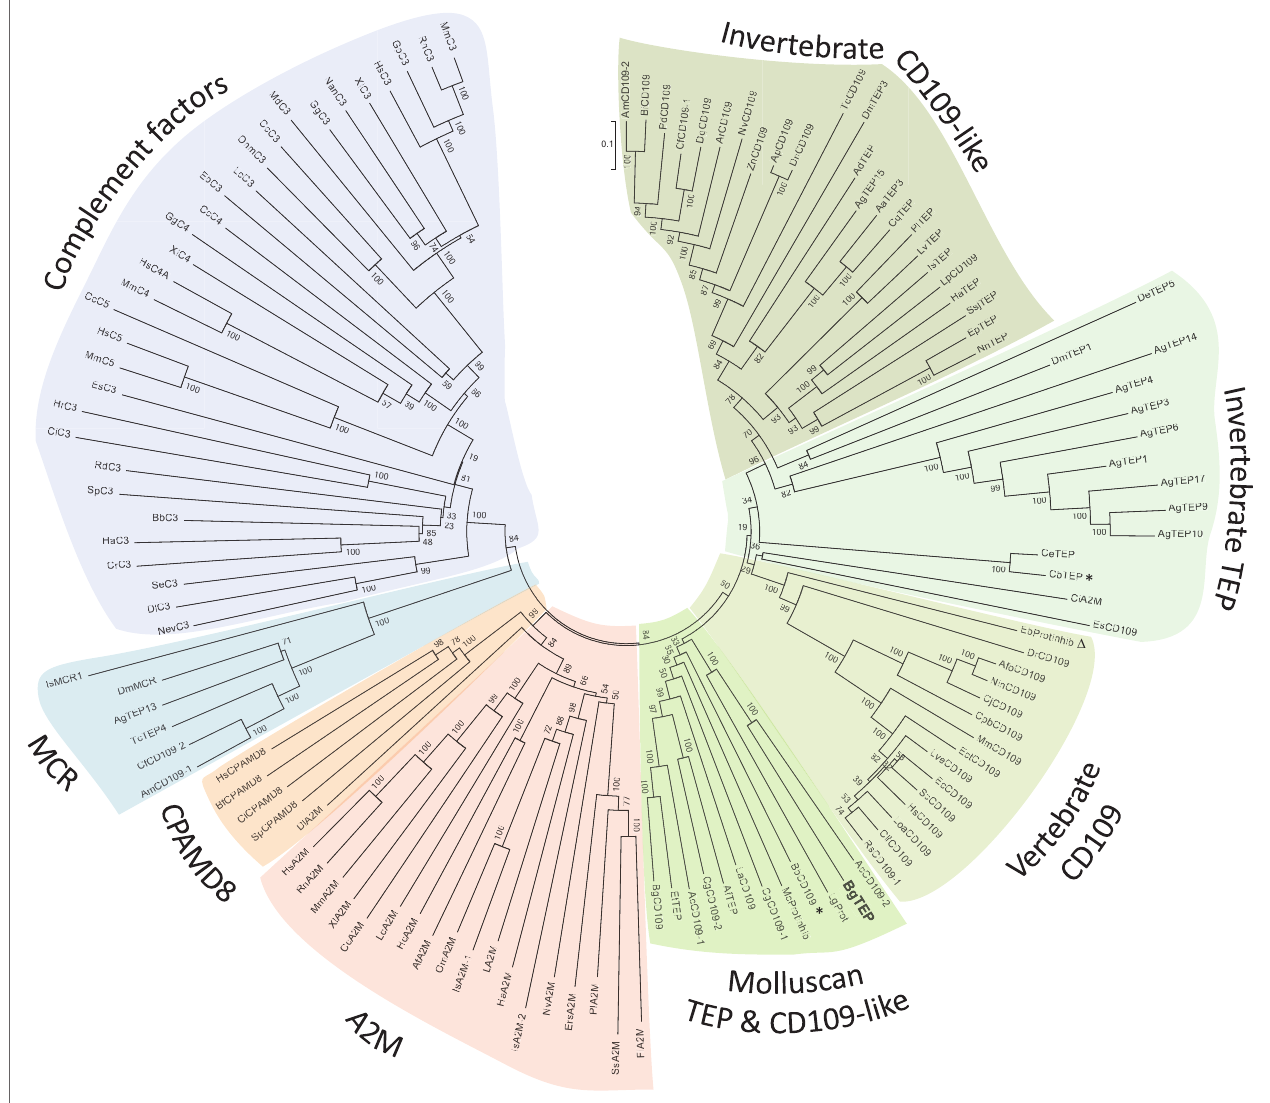
FigUre 2 | Phylogenetic tree of thioester-containing protein (TEP) superfamily. Phylogenetic analysis of the TEP superfamily full-length protein sequences from 125 members (see Table S2 in Supplementary Material). Complement factor groups are colored in blue shades, alpha-2 macroglobulin groups in red shades, and insect thioester-containing protein and CD109 groups in green shades. BgTEP is indicated in bold type. A bootstrap analysis of 2,000 replications was carried out on the tree inferred from the neighbor-joining method and the values are shown at each branch of the